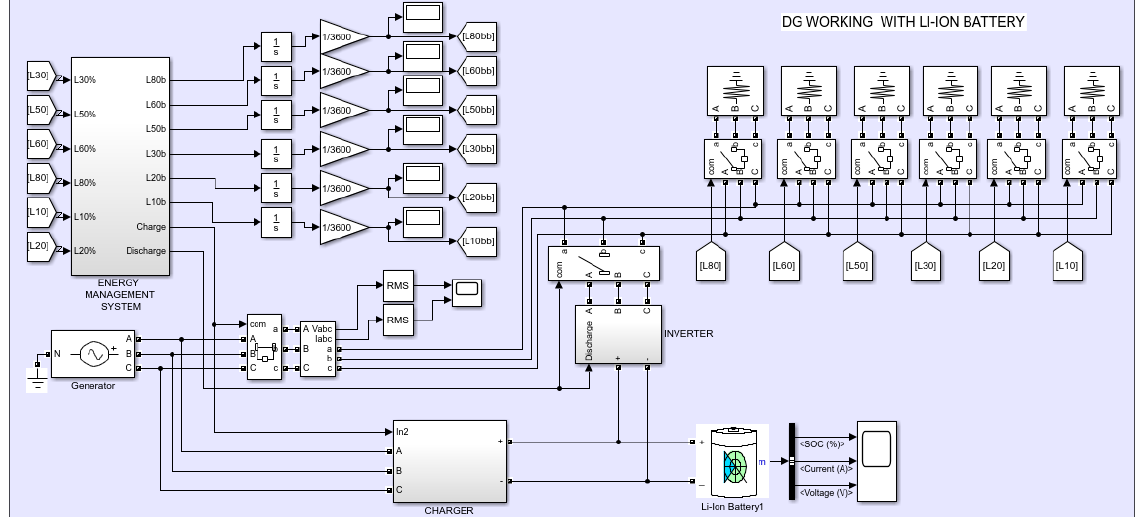
Figure 4. DG working with Li-ion battery.